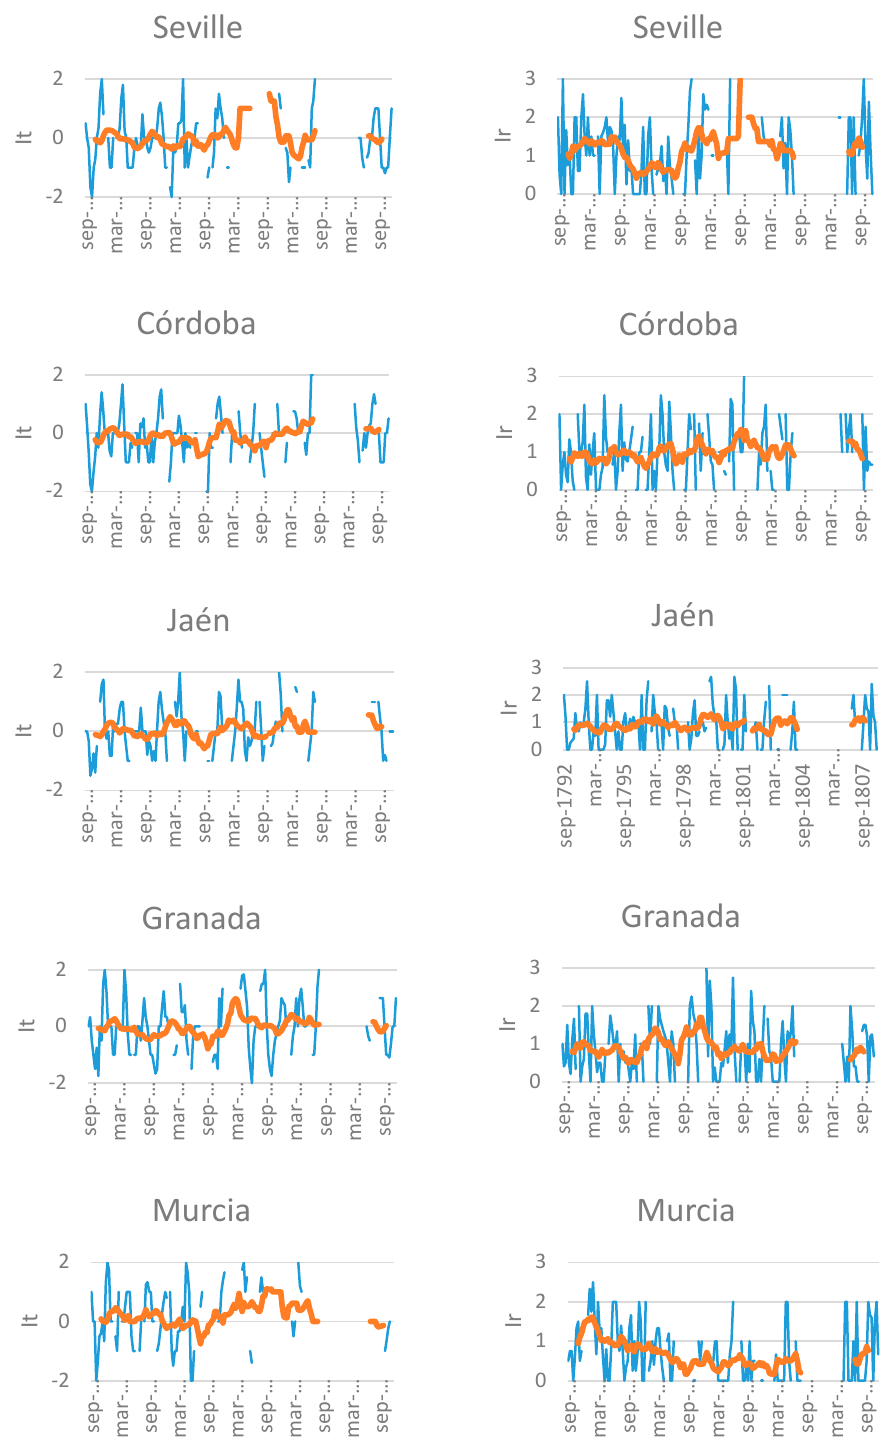
Figure 4. Thin line: time series of the monthly indices I t (left), and I r (right) for the five provinces studied. Thick line: 13-month moving average.